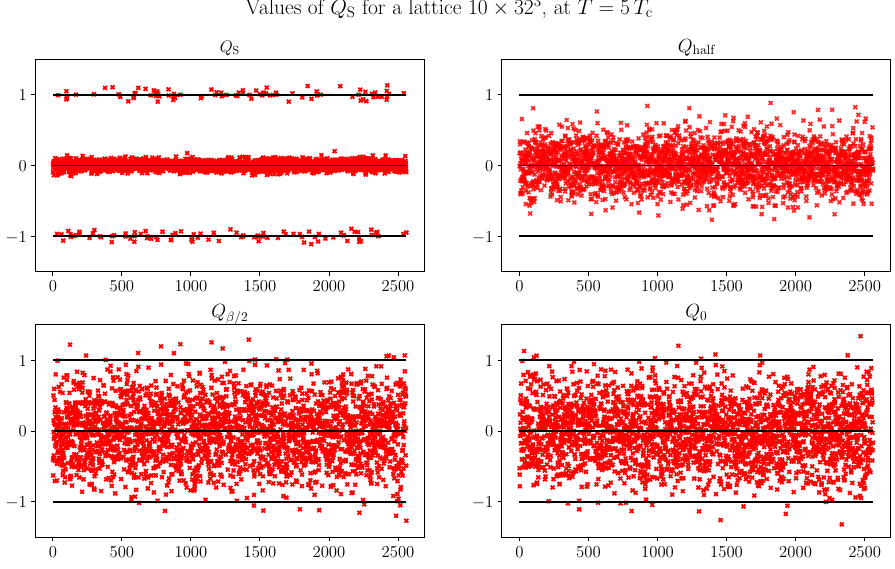
Figure 7 . Numerical data obtained from 2560 configurations on a lattice with 10 × 32 3 sites, equilibrated at a temperature T = 5 T c , where the measurement has been performed at a gradient flow depth of τ = 1 . 2 a 2 . The top-left plot is Q S of each configuration, and is approximately F an integer. The top-right, bottom-left, and bottom-right plots show the Q half , Q 0 , and Q respectively.